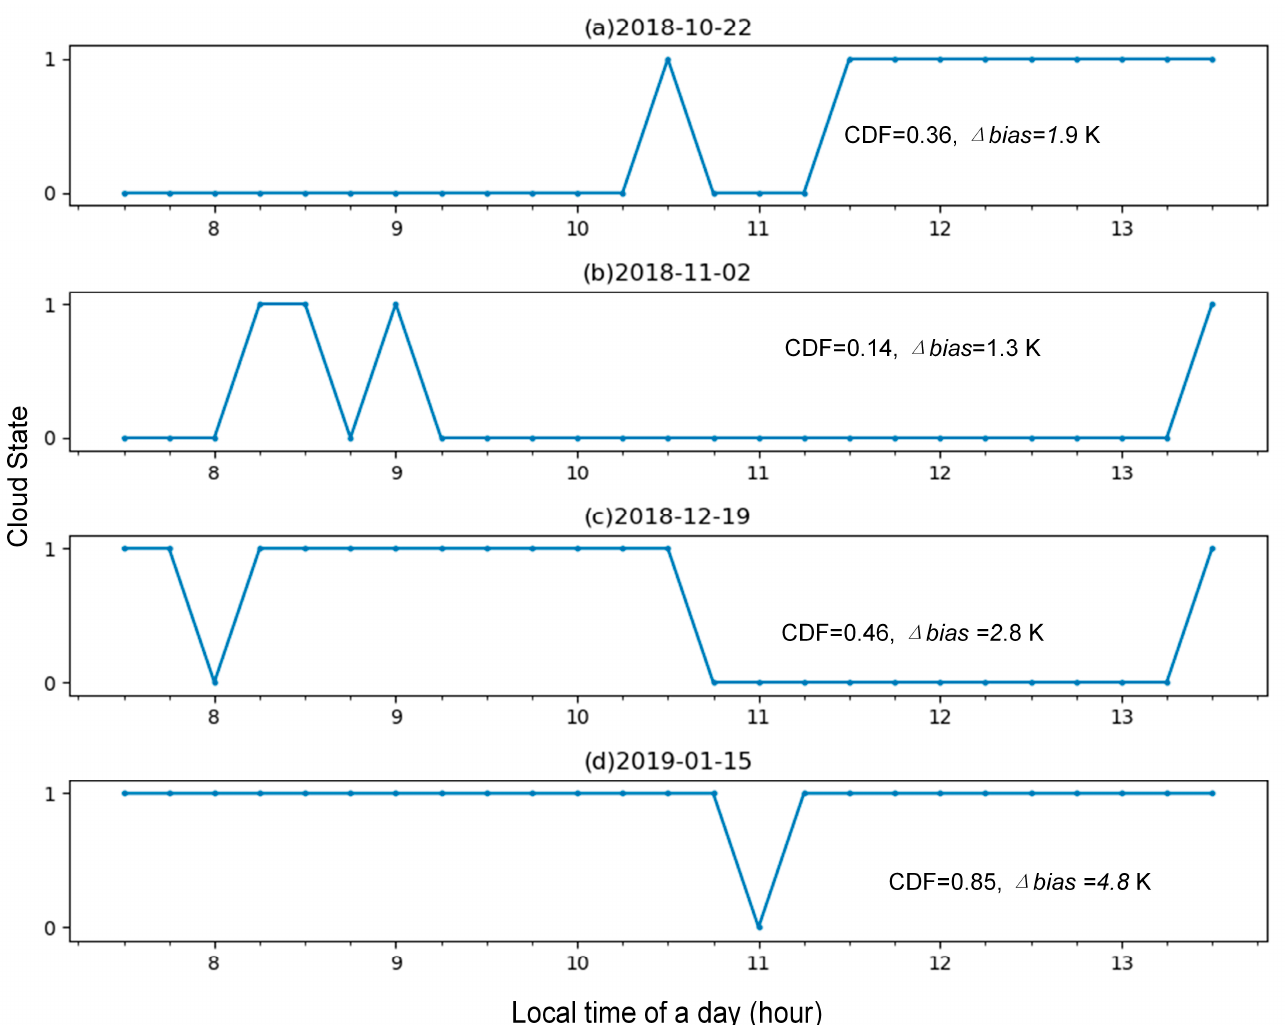
Figure 11. Time series of cloud state reported using the in situ data record from the upward pointing LWIR radiometer installed at the ILRI Kapiti Research Station between 7:30 a.m.–1:30 p.m. for the four dates selected and reported in Figure 6, ( a ) 22 October 2018; ( b ) 2 November 2018; ( c ) 19 December 2018; and ( d ) 15 January 2019. A value of 1 = stable cloud was present for at least the prior 15 min, whilst a value of 0 = stable cloud was not present for the 25 min prior to the LST derivation. Cloud duration fraction (CDF) and Δ bias values are reported for each sub-Figure and defined at the start of Section 4.4.